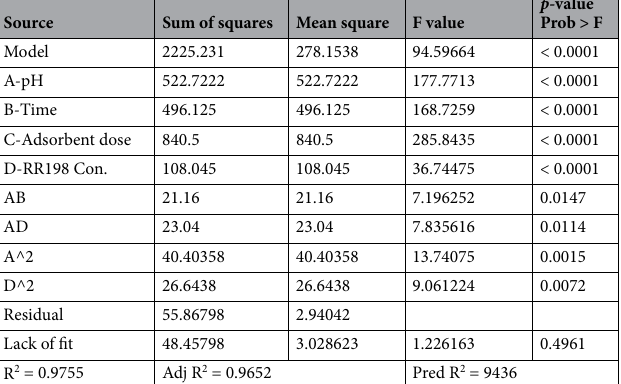
Table 5. ANOVA results and determination coefficients for the BBD-RSM model developed for the treatment process.